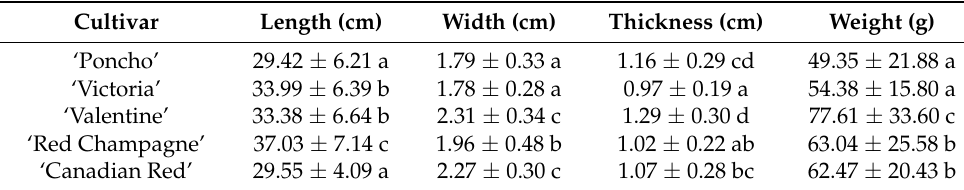
Table 1. Cont. Morphological Description of Petiole Picture of the Petioles * Erect attitude, type of cross-section 2, green ground color of skin, entire distribution of skin superimposed color at base, speckled distribution of skin superimposed color at ‘Victoria’ middle, absent distribution of skin superimposed color just below leaf blade, present hairiness just below leaf blade, weak ribbing of dorsal side, green color of flesh Erect attitude, type of cross-section 3, red ground color of skin, entire distribution of skin superimposed color at base, speckled distribution of skin superimposed color at ‘Valentine’ middle, speckled distribution of skin superimposed color just below leaf blade, absent hairiness just below leaf blade, medium ribbing of dorsal side, pink color of flesh Erect attitude, type of cross-section 2, red ground color of skin, entire distribution of skin superimposed color at base, speckled distribution of skin superimposed color at ‘Red Champagne’ middle, speckled distribution of skin superimposed color just below leaf blade, present hairiness just below leaf blade, weak ribbing of dorsal side, green color of flesh